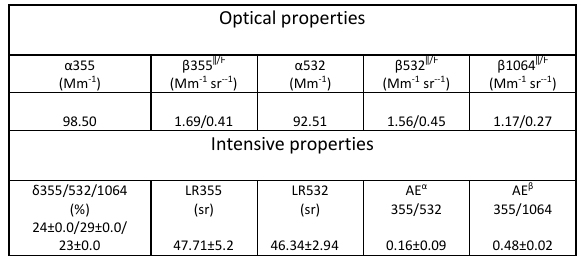
Table 1. Dust layer 2-2.75 km